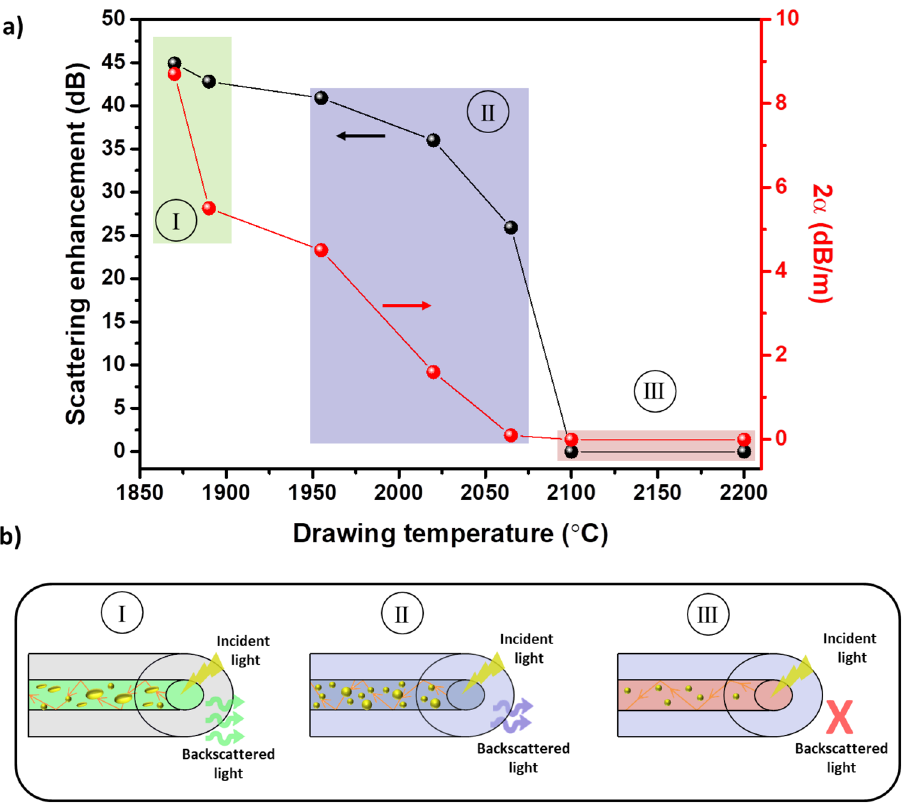
Figure 4. ( a ) Scattering enhancement (left axis) and two-way attenuation, 2α, (right axis) versus drawing temperature for Ca-based nanoparticles doped silica fiber. ( b ) Schematic model showing the influence